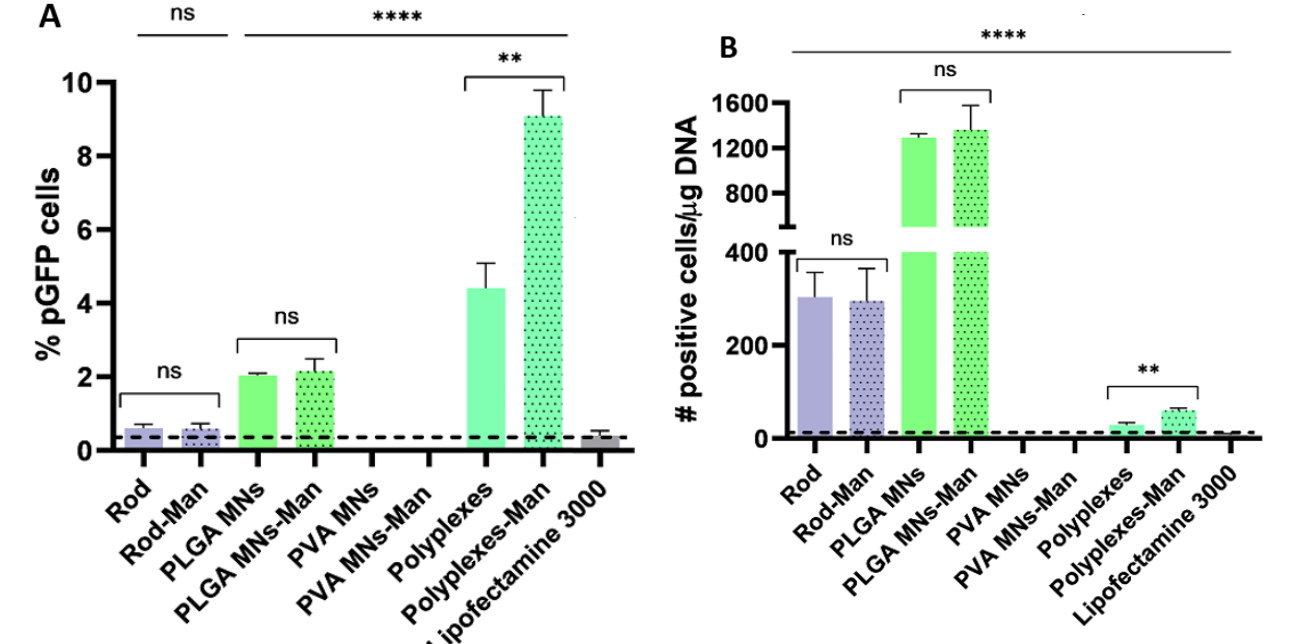
Figure 7. Screening of pGFP expression in MoLCs cells by flow cytometry following transfection with PBAE-based delivery systems ( A ). Number of transfected cells theoretically normalized to the amount of pDNA added per well during transfection ( B ). Values from our previous dsDNA quantification assay in rods were extrapolated for coated MNs. Data are represented as mean ± SD. Unless stated, statical significance was determined against Lipofectamine3000 (dashed line) as the control group (ns = non-significant, ** p < 0.01, **** p < 0.0001).